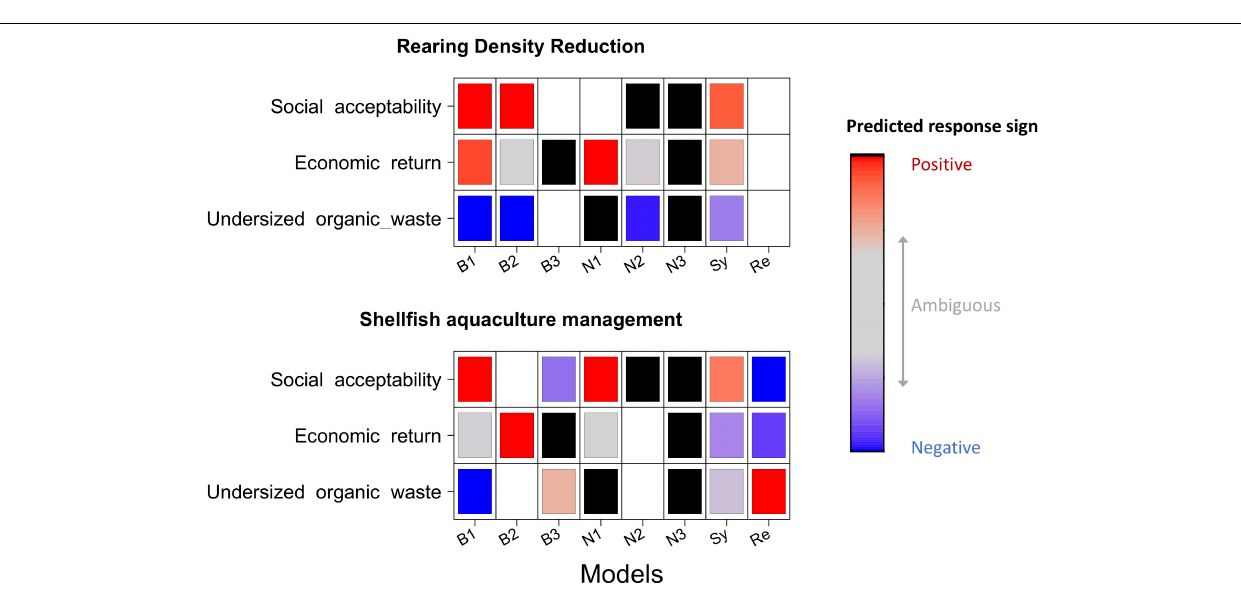
FIGURE 5 | Predicted qualitative responses of variables to alternative perturbation scenarios ( x -axis, from left to right: increase in lease area, decrease in farming and land uses, intensification of waste collection, improvement in shellfish aquaculture management, improvement in integrated management, and decrease in rearing density) according to the synthetic model ( Figure 4 ). Legend: colored squares represent the sign of response of each variable ( y -axis) to a given scenario ( x -axis): white for neutral (no effect of the scenario on response variable); gray for ambiguous; red for positive; blue for negative. When responses are positive or negative, the degree of shading increases with prediction uncertainty.